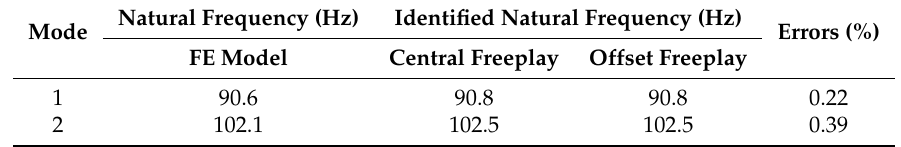
Table 3. The natural frequencies identified by TNSI